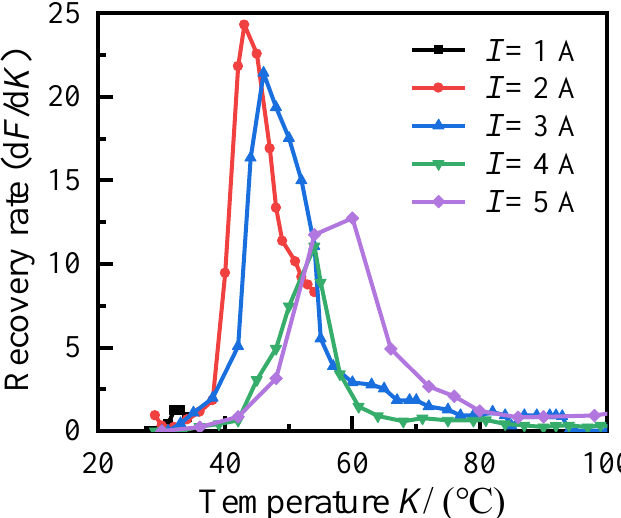
Figure 12. Relationship between recovery rate and temperature.